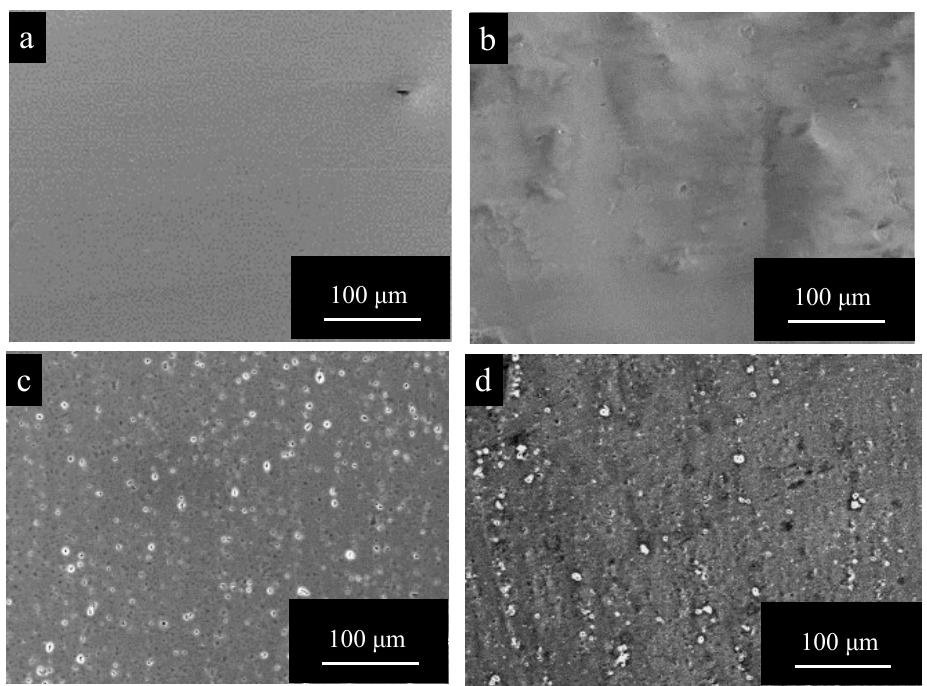
Figure 5. SEM images of surfaces of ( a ) pure Al, ( b ) 1050-al alloy, ( c ) 3003-Al alloy, and ( d ) 5052-Al alloy specimens after anodizing for t a = 3600 s. Anodizing conditions are described in Figure 3. Figure 6 shows SEM images of the vertical cross section of (a) pure Al, (b) 1050-al alloy, (c) 3003-Al alloy, and (d) 5052-Al alloy specimens after anodizing for t a = 1800 s. Each image consists of three layers, as follows: a top layer of embedding resin, a mid- dle layer of oxide film, and a bottom layer of metal substrate. The thickness of oxide films on pure Al, 1050-Al alloy, and 5052-Al alloy is about δ = 15 μ m and is larger than that on 3003-Al alloy.